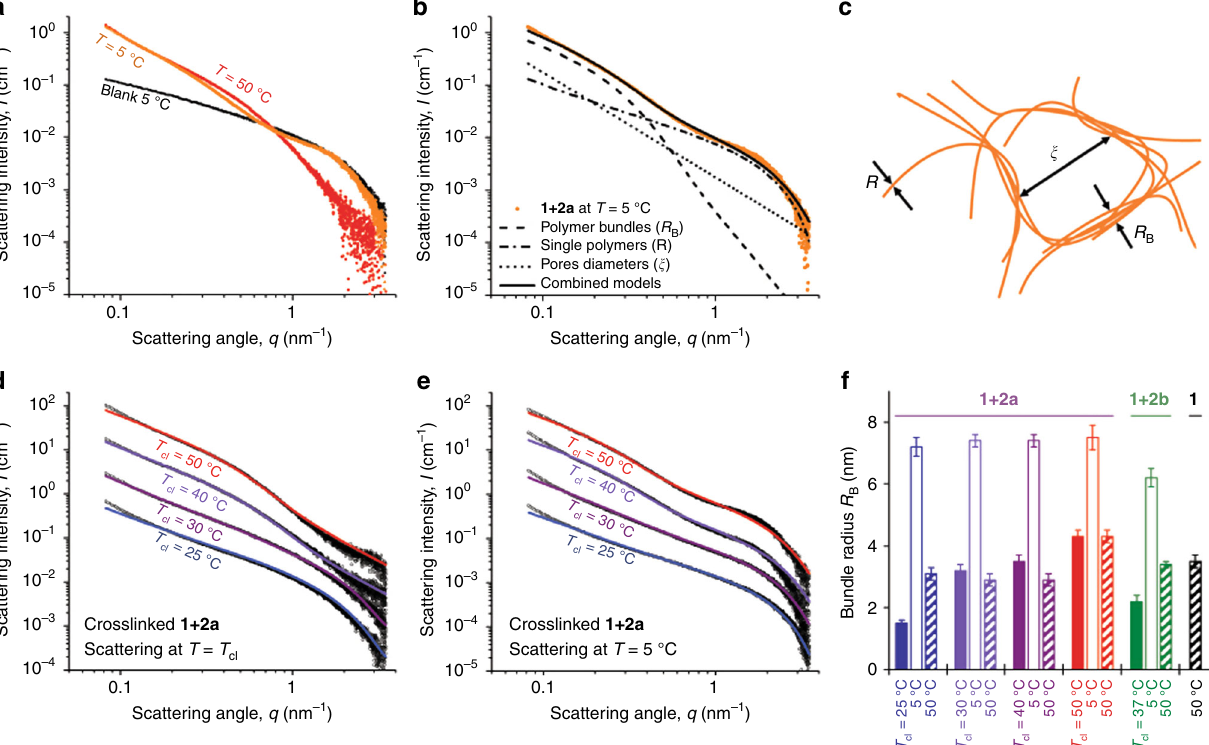
Fig. 3 Architectural analysis with SAXS. a The scattering curve of the 1 + 2a crosslinked gel at 5 °C (orange) is a combination of the bundled hydrogel pattern (red, 1 + 2a , 50 °C) and the dissolved polymer pattern (black, 1 , 5 °C). b , c Contributions of the models for crosslinked 1 + 2a gel at 5 °C and model interpretation of architectural length scales. d , e SAXS curves of 1 + 2a gels, crosslinked at 25, 30, 40, and 50 °C at the crosslinking temperatures ( d ) and after cooling to 5 °C ( e ) with the best fi t to the model (solid lines). The curves were shifted vertically to enhance clarity; un-shifted curves are given in Supplementary Fig. 5. f Average bundle radii of gels crosslinked gels 1 + 2a (blue to red) and 1 + 2b (green) at the crosslinking temperature T cl , at 5 °C and at 50 °C, as well as the bundle radius of 1 at 50 °C for comparison. All fi ts include a 40% distribution on the bundle diameter; the error bars are an estimate for the range where the fi t yields acceptable results. The concentrations for all samples in the fi gure are [ 1 ] = 4 mg mL − 1 and [ 2a ] = [ 2b ] = [N 3 ]/2 = 208 µ